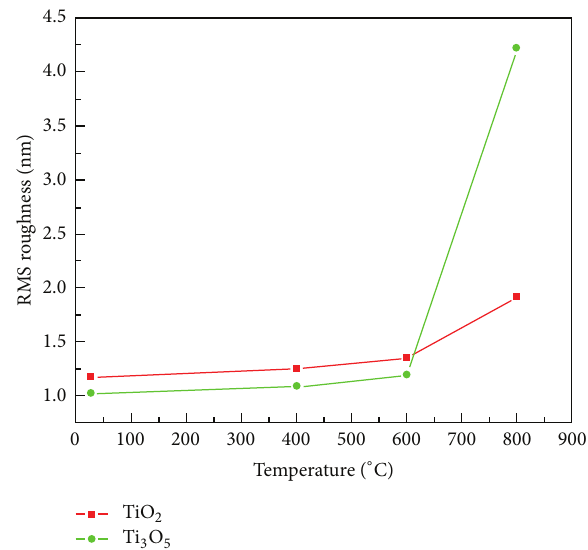
Figure 7: Influence of annealing temperature on RMS roughness of TiO 2 films from Ti 3 O 5 and TiO 2 starting materials.